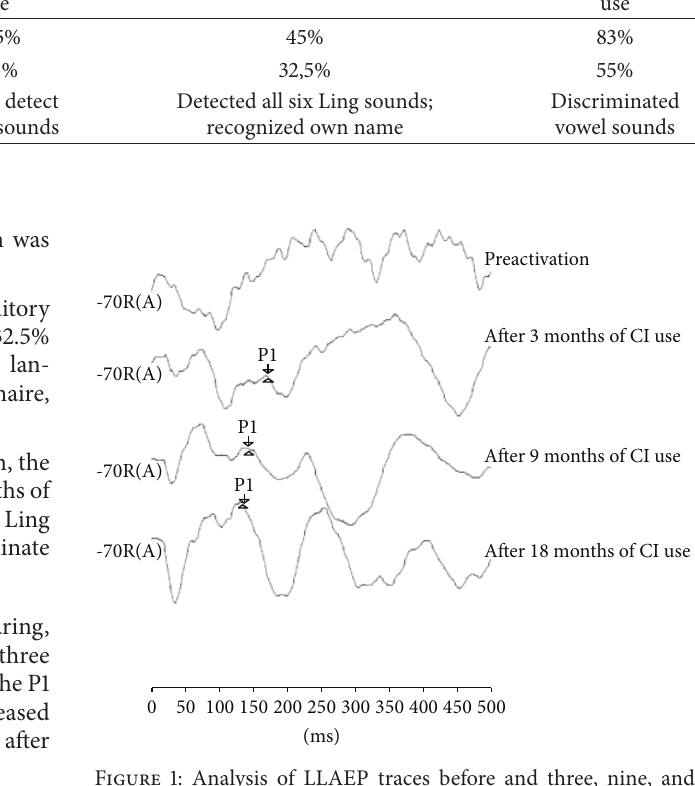
Figure 1: Analysis of LLAEP traces before and three, nine, and eighteen months after activation of electrodes of the